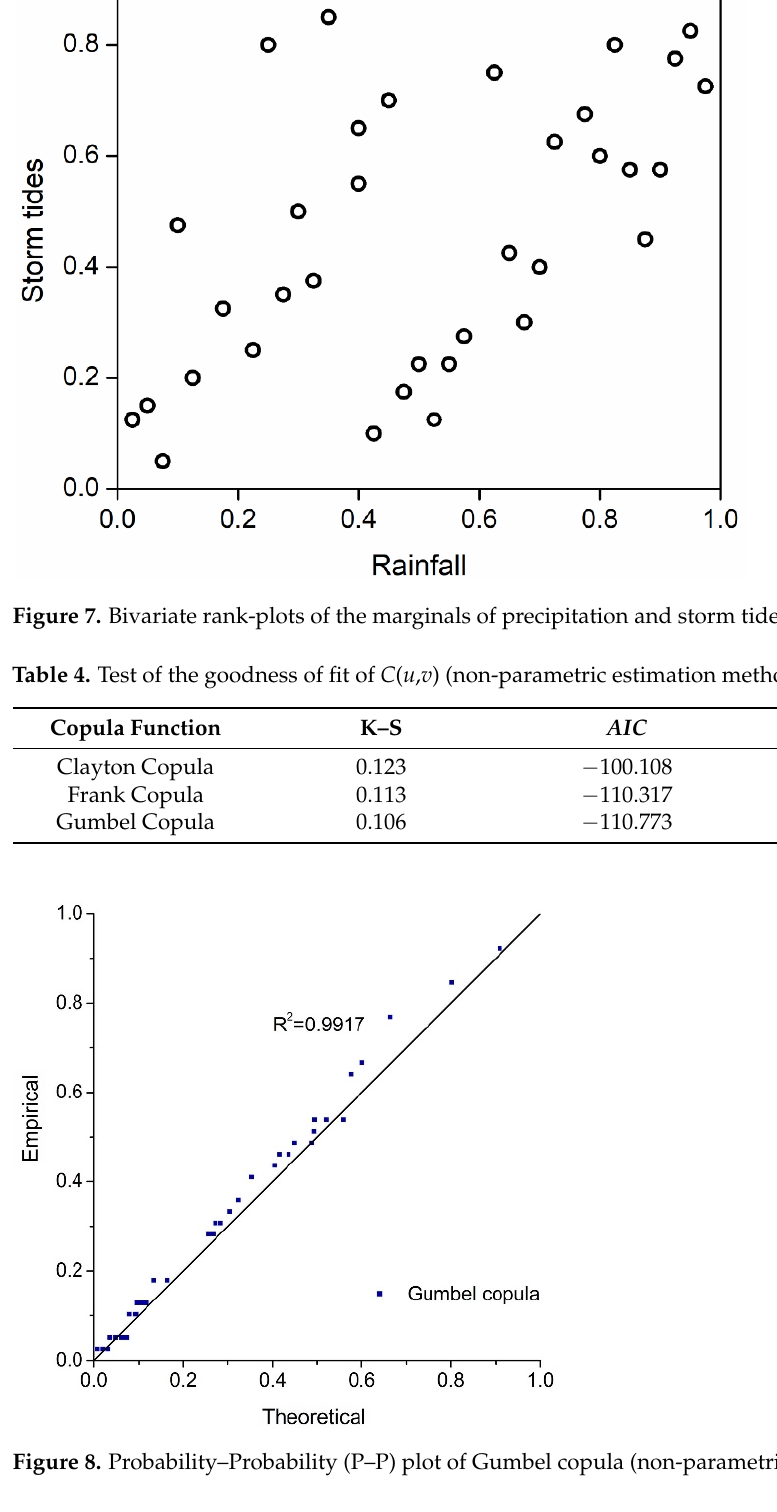
Figure 8. Probability–Probability (P–P) plot of Gumbel copula (non-parametric estimation method).